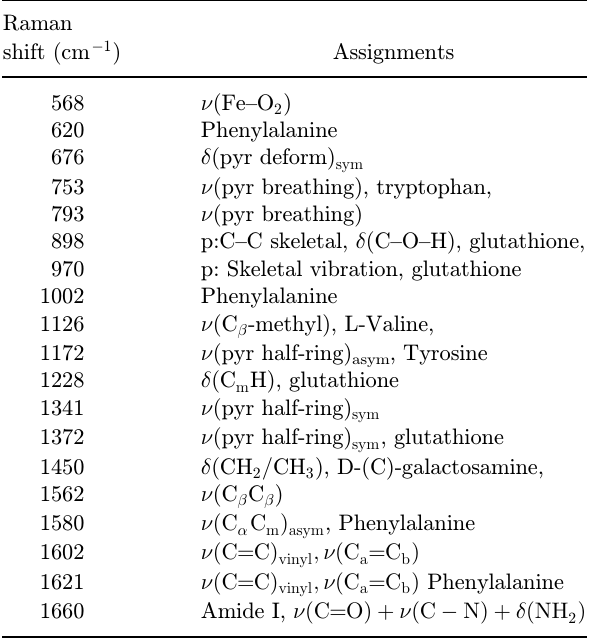
Table 1. Raman peak positions and tentative assignments. 8 – 10